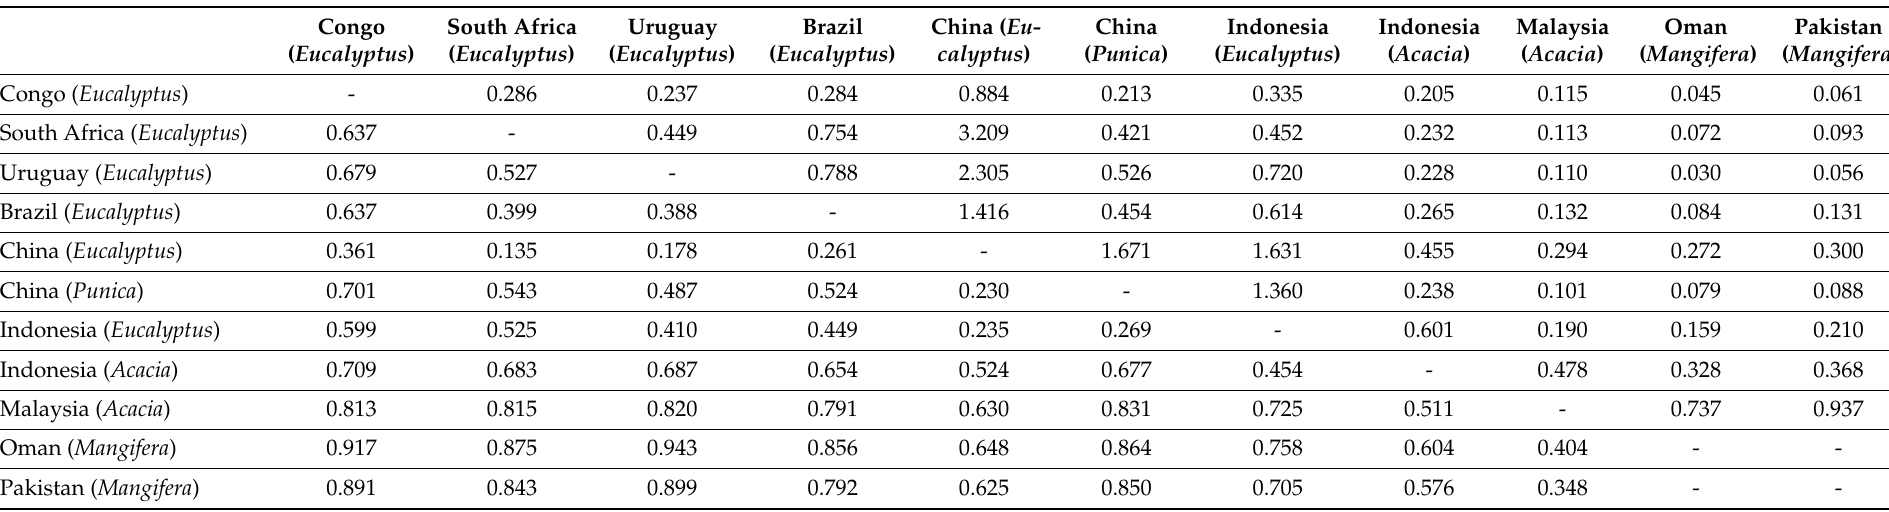
Table 3. Population differentiation of all the Ceratocystis populations separated based on country and host. Pairwise comparison of population differentiation ( ϕ PT) and gene flow (Nm) among the populations are presented below and above the diagonal,